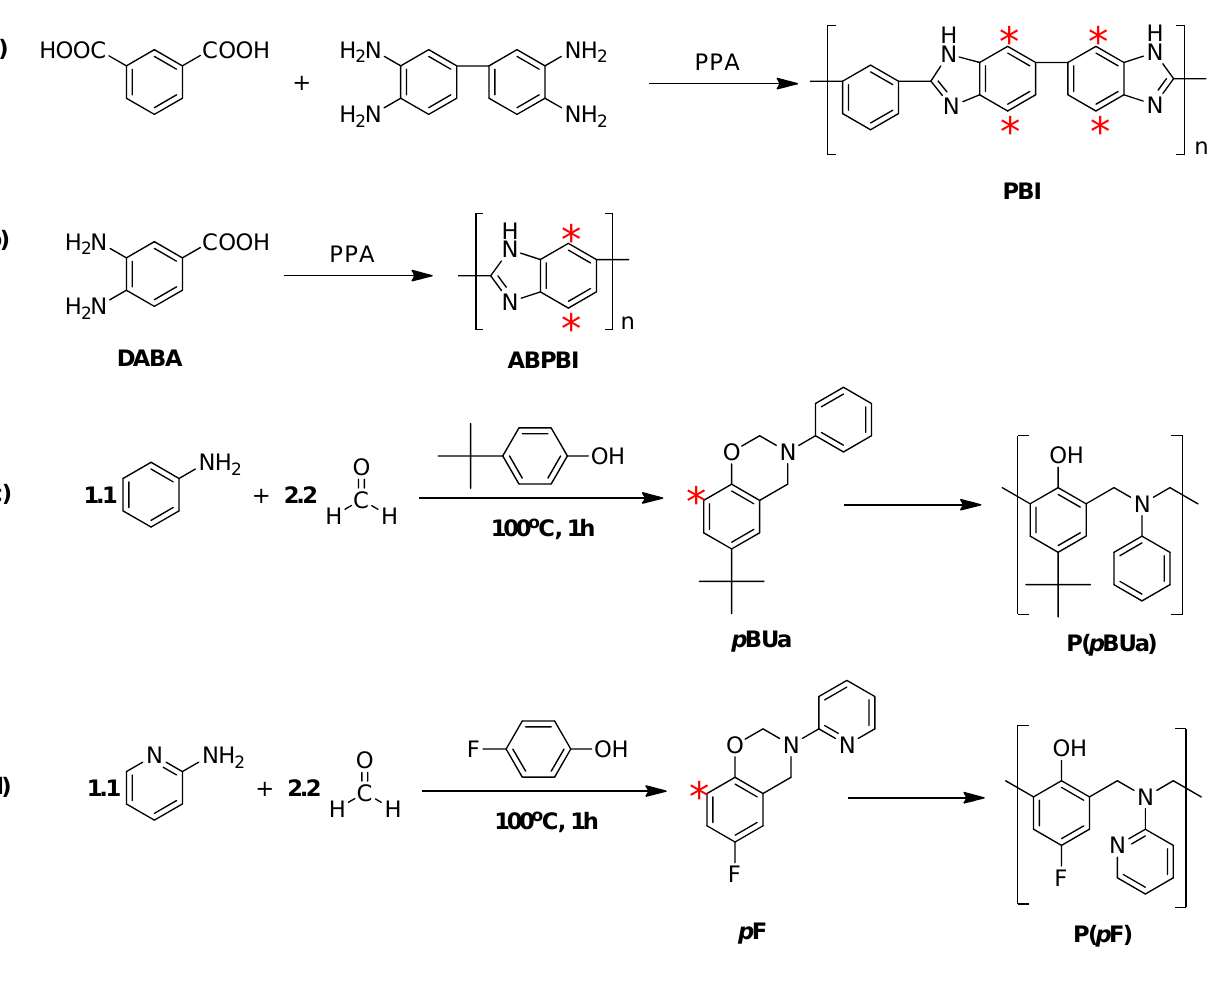
Figure 1. Synthesis of ( a ) polybenzimidazole (PBI); ( b ) poly(2,5-benzimidazole) (ABPBI); ( c ) 6-(Tert-butyl)-3-phenyl-3,4-dihydro-2H-benzo[e][1,3]oxazine ( p BUa) and P( p BUa); and ( d ) 6-Fluoro-3-(pyridine-2-yl)-3,4-dihydro-2H-benzo[e][1,3]oxazine ( p F) and P( p F) (asterisks indicate possible crosslinking